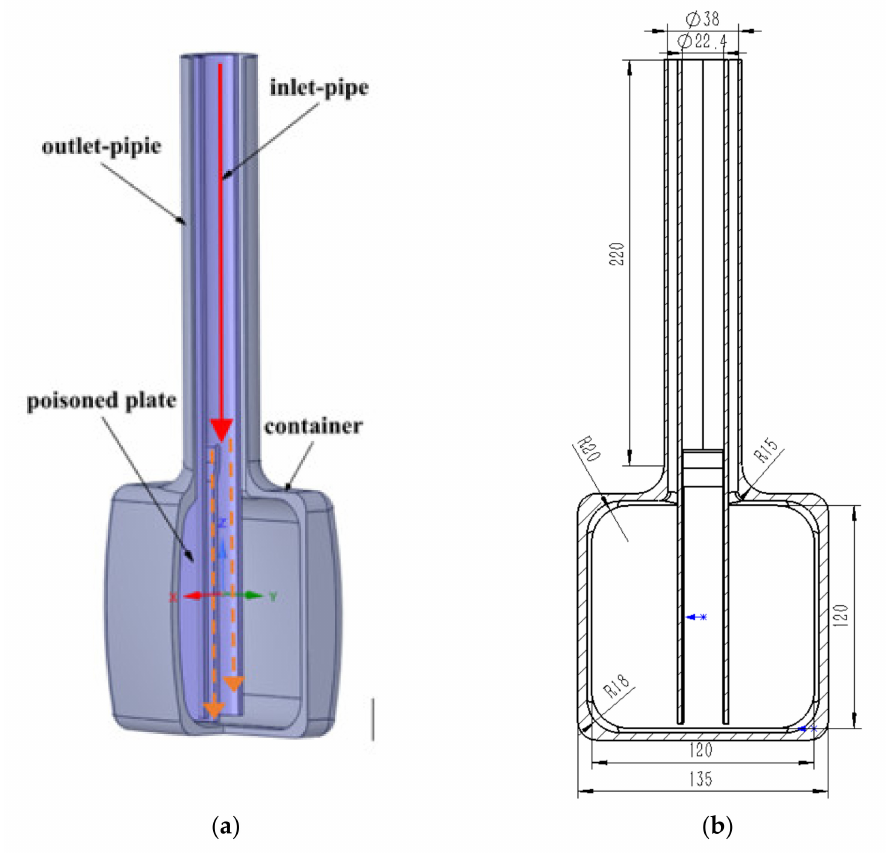
Figure 1. The Computational Model of DPHM: ( a ) Model Diagram; ( b ) Detailed Size